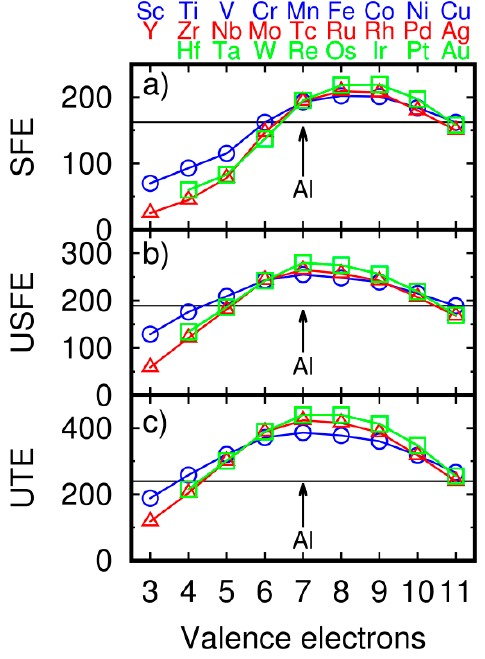
Figure 3. ( a ) Stacking fault energy (SFE), ( b ) unstable stacking fault energy (USFE), and ( c ) unstable twinning energy (UTE) of aluminum-transition metal alloys. The black line on each plot is a value of considered energy of pure Al. The circle, triangle and square denote 3d, 4d and 5d elements, respectively. All energies are in mJ/m 2 .